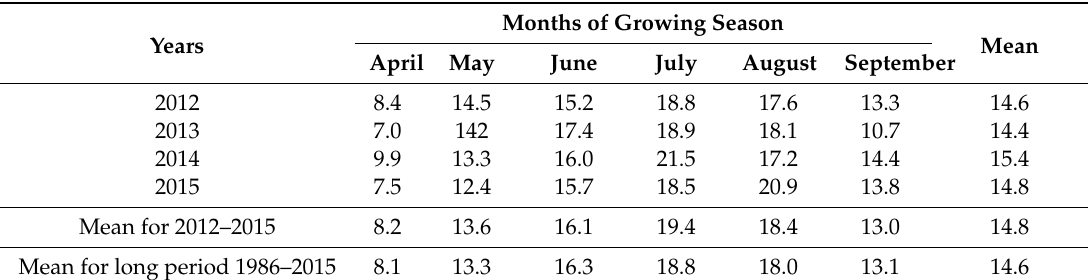
Table 2. Monthly mean air temperature ( ◦ C) data during the growing season of two watermelon cultivars: Bingo and Sugar Baby (2012–2015).